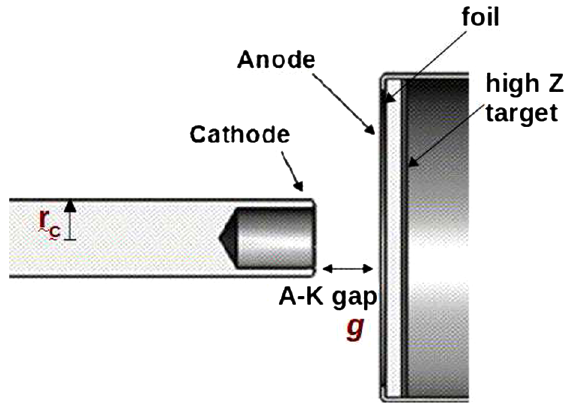
FIG. 1. Cross-sectional diagram of the SMP diode. The diode geometries considered here are distinguished by their ratio of anode-cathode (A-K) gap to cathode radius ( g=r